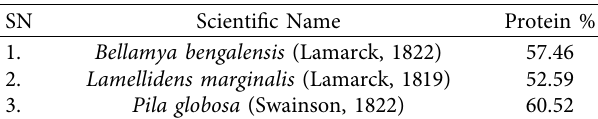
Table 8: Mollusk’s species that can be promoted for rearing in